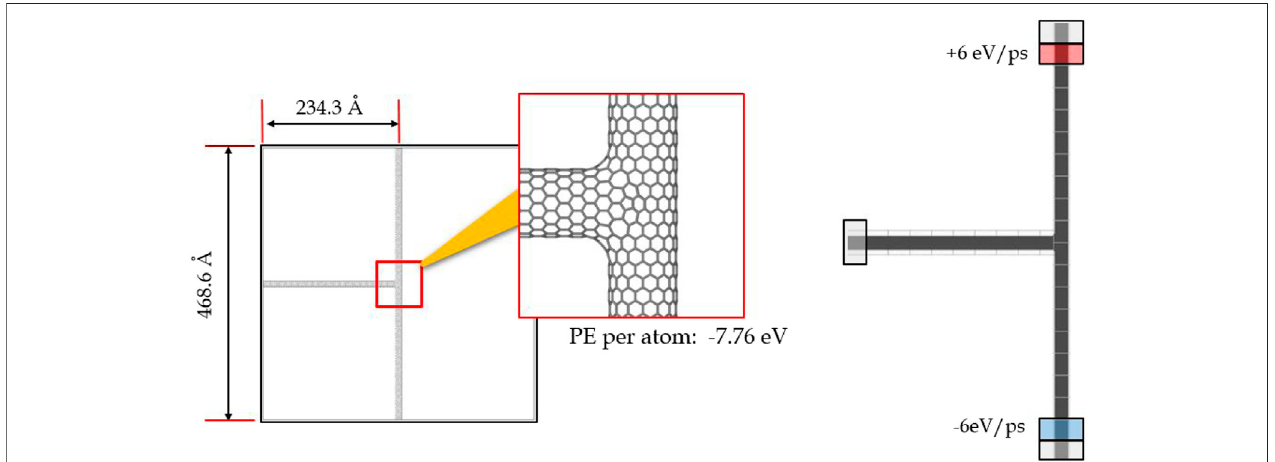
FIGURE 6 | Schematic diagram showing RNEMD method for determining thermal conductivity of 3T-Junction.